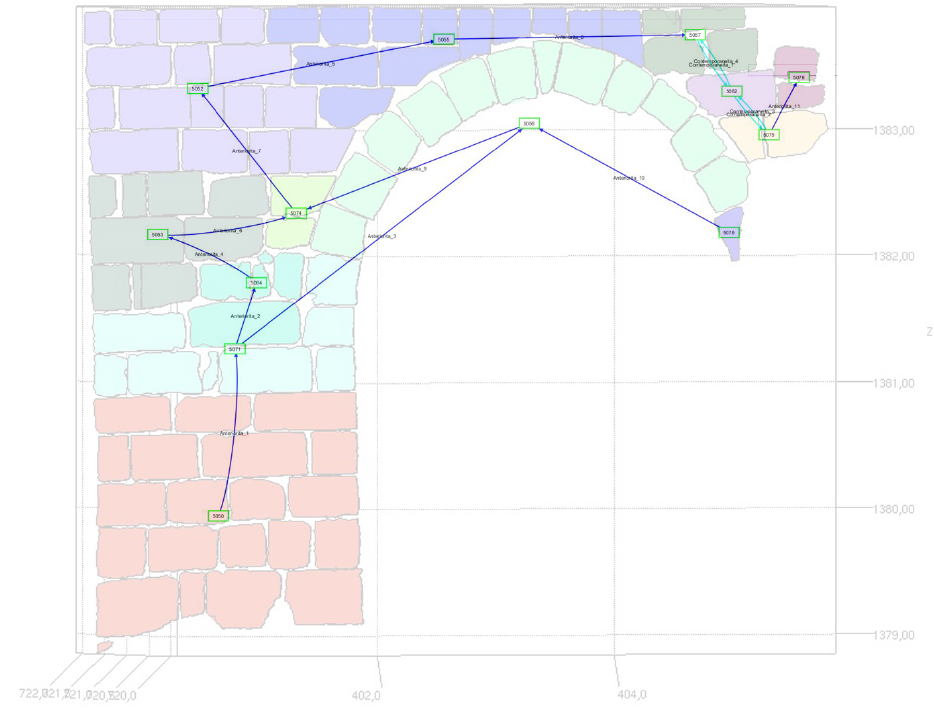
Figure 14. Positive stratigraphic relations with the USM node coordinate coming from photogrammetric